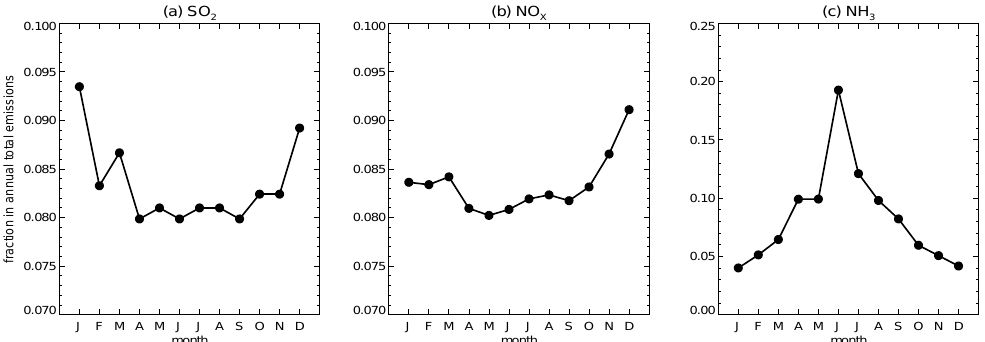
Fig. 2. Seasonality of (a) SO 2 , (b) NO x and (c) NH 3 emissions from